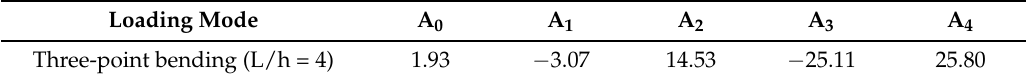
Table 1. Value of A 0 , A 1 , A 2 , A 3 and A 4